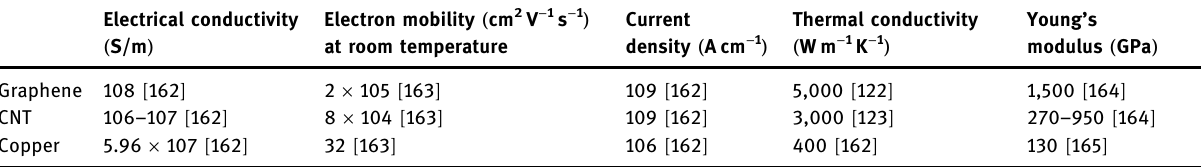
Table 1: The electrical, thermal, and mechanical properties of graphene, CNTs, and copper ( the metal that most commonly used in antenna ) Electrical conductivity ( S/m